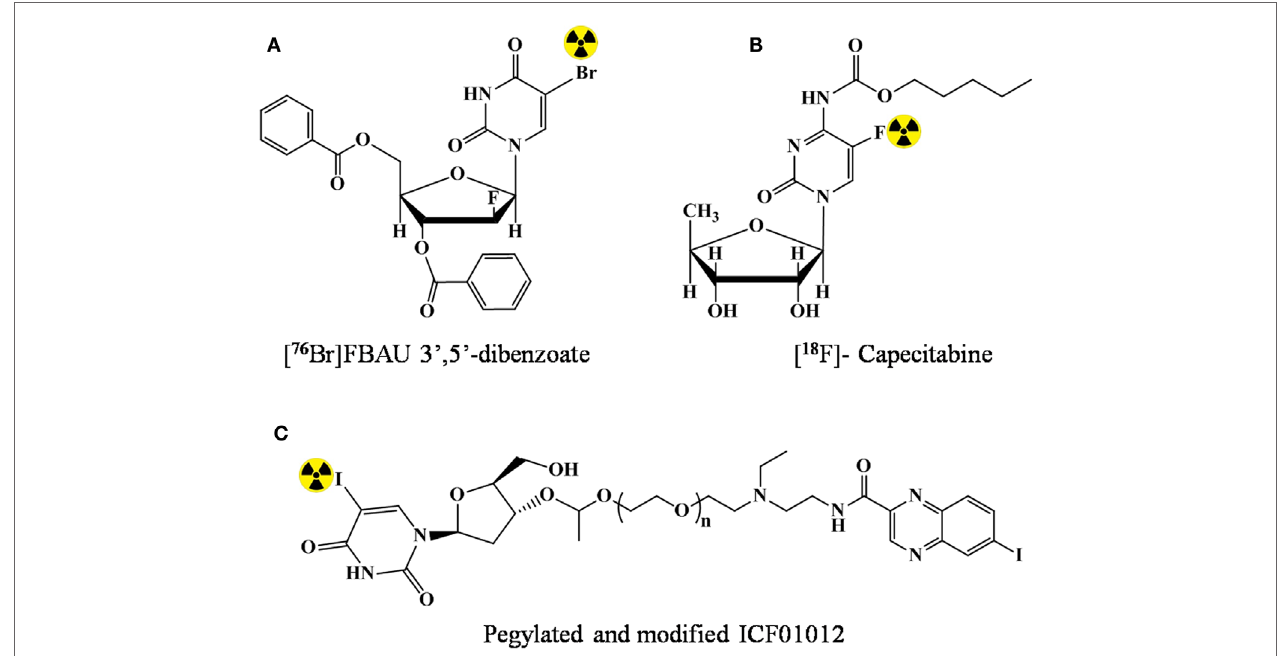
FiGURe 3 | Lipidic modification of the nucleosides for prodrug strategy. (A) [ 76 Br]FBAU 3 ′ ,5 ′ -dibenzoate, (B) [ 18 F]-Capecitabine, and (C) pegylated and modified